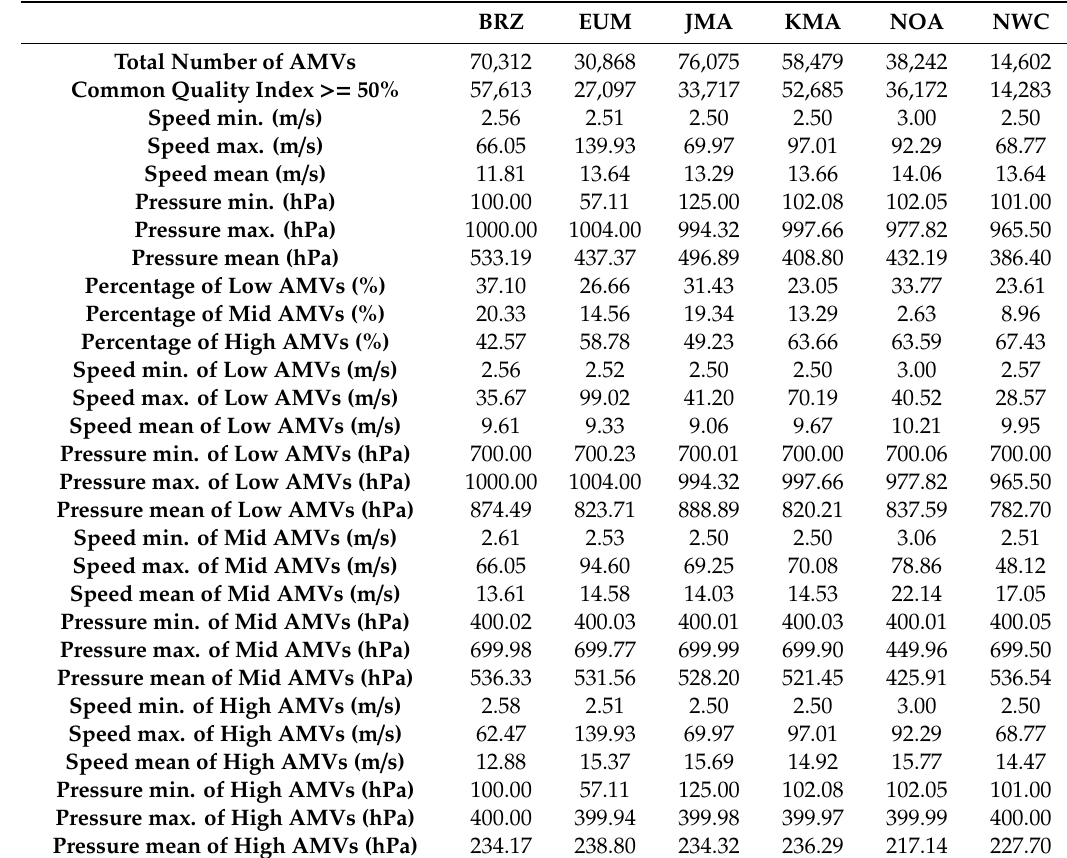
Table 2. Parameter distribution for the di ff erent AMV datasets in Experiment 1 with CQI >=